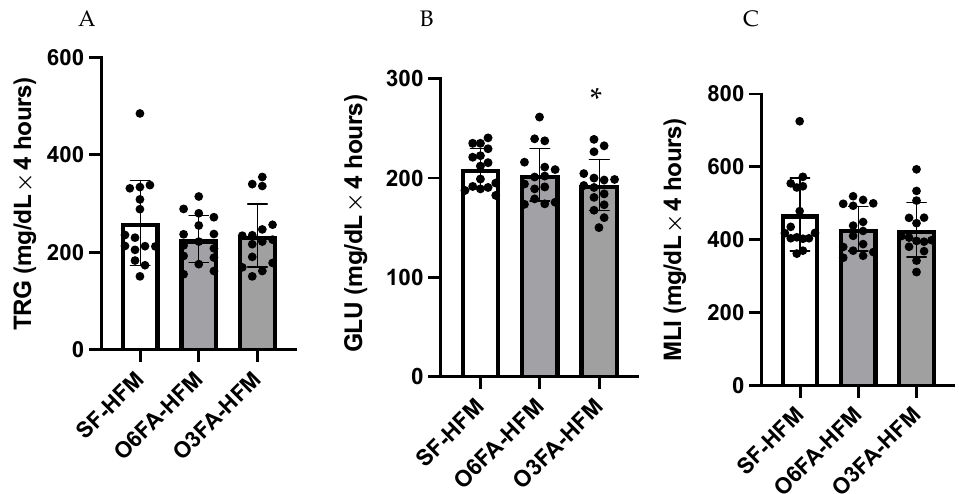
Figure 2. ( A – C ). Area under the curve for the postprandial metabolic responses. TRGs ( A ), GLU ( B ), and MLI ( C ) are displayed with each black filled-in circle representing individual participant data. * Indicates significance as an interaction between time and smoothie type. TC, HDL-C, and LDL-C are displayed is Figure 3A–C. There was no significant dif- ference across time points for TC ( p = 0.184), among smoothie types ( p = 0.353), or as an interaction between time and smoothie type ( p = 0.135). There was no significant differ- ence across time points for HDL-C ( p = 0.714), among smoothie types ( p = 0.456), or as an interaction between time and smoothie type ( p = 0.701). There was a significant difference across time points for LDL-C ( p = 0.001). While there was no difference by smoothie type alone ( p = 0.589), there was a significant interaction between LDL-C and smoothie type ( p = 0.041). This was driven by the drop in LDL-C at 2 h ( p = 0.013), followed by the increase from 2 h to 4 h in the SF condition ( p = 0.046), which did not occur in the O6FA or O3FA conditions.